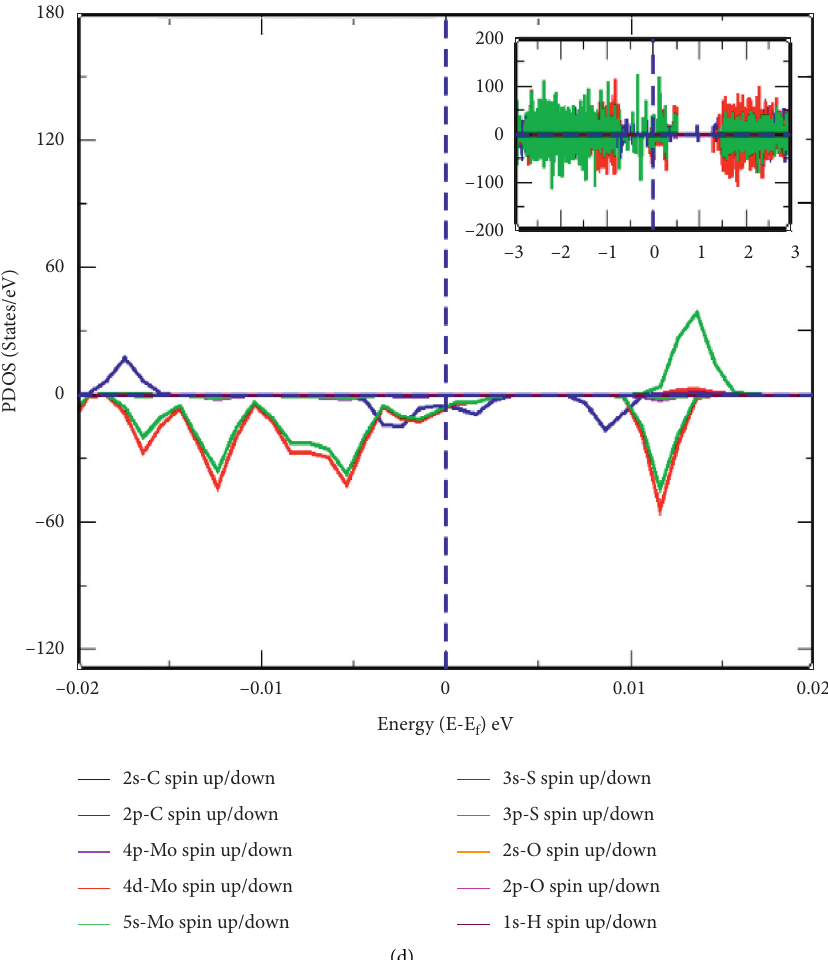
Figure 4: (a) Band structure of system-IIa, (b) DOS of up-spin and down-spin states of electrons in the orbitals of C Mo, S O, and H atoms of system-IIa, (c) PDOS of total up-spin and total down-spin states of electrons in the orbitals of C Mo, S O, and H atoms of system-IIa, (d) PDOS of individual up-spin and down-spin states of electrons in the orbitals of C Mo, S O, and H atoms of system-IIa. In all DOS and PDOS, the horizontal dot line separates spin states and the vertical dot line separates the electronic bands, and also in the band plot, the horizontal dot line represents the Fermi energy level. Insets in DOS and PDOS represent spin states within large energy range along x